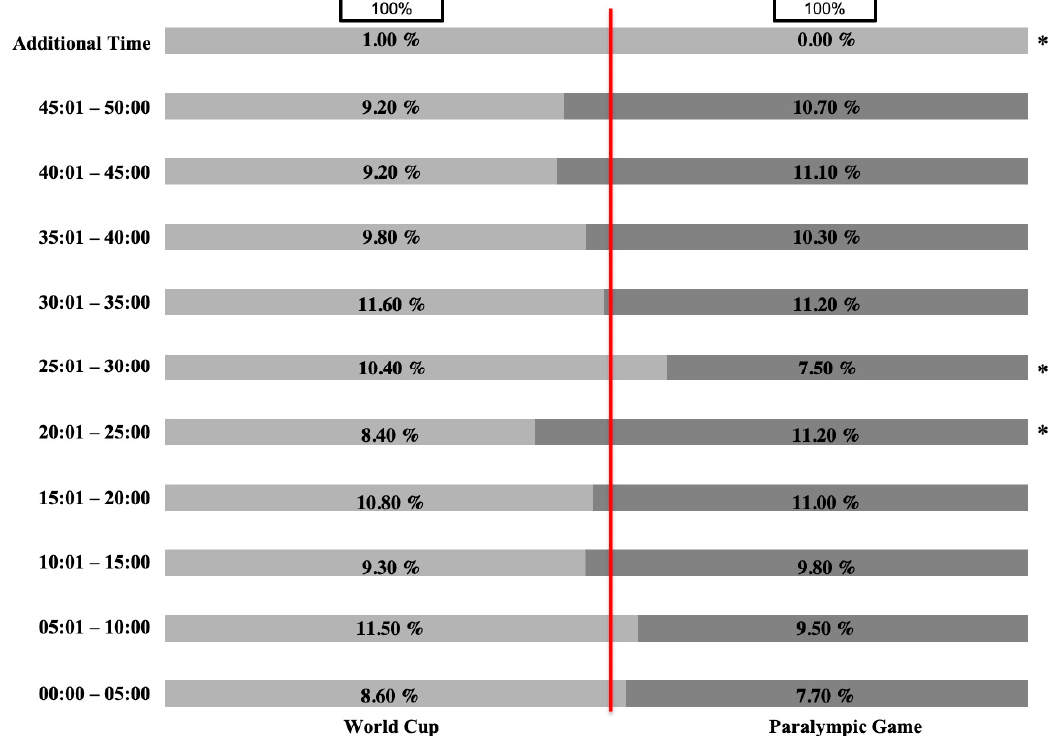
Table 3. Descriptive results and the ASRs of the match status variable.